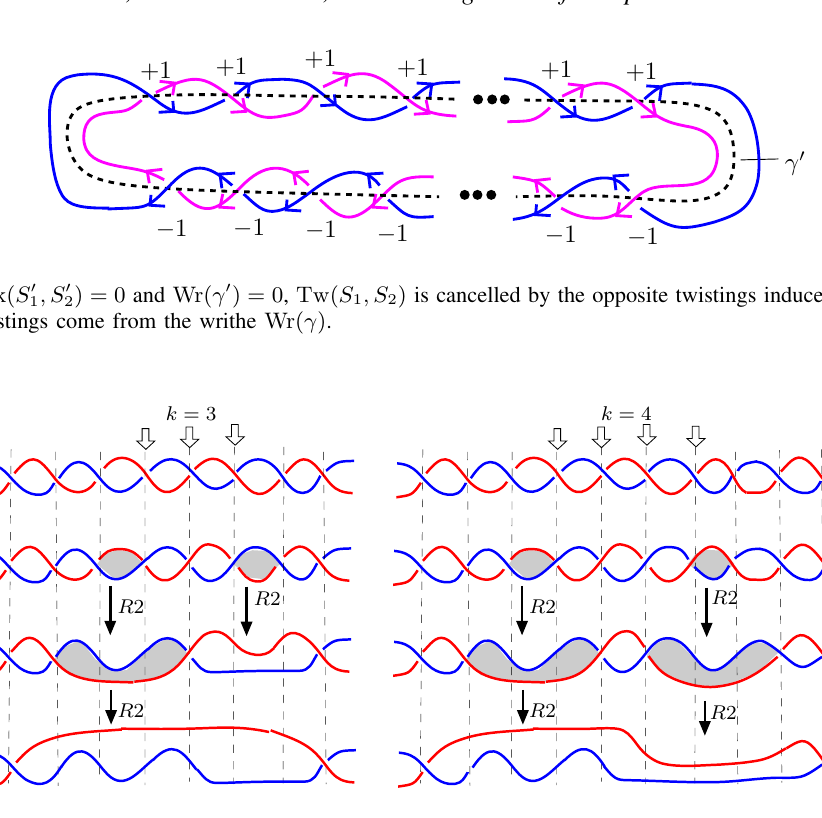
Fig. 10. The white arrows indicate the places where unknotting operations are applied; k = 3 (left) and k = 4 (right). The black arrows indicate the places that the Reidemeister moves R 2 are applied. The both cases need 2